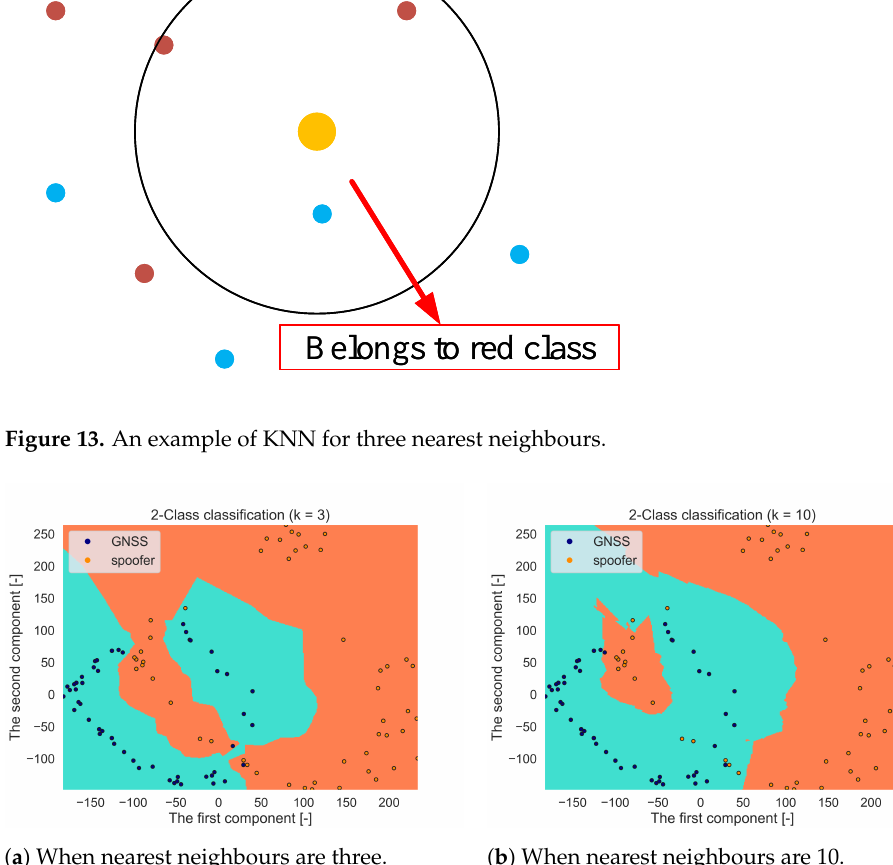
Figure 14. An example based on Galileo E1 and spoofer simulated data: the first two principal components of PCA of spectrogram images are classified by KNN under a different number of nearest neighbours: 3 ( left ) and 10 ( right